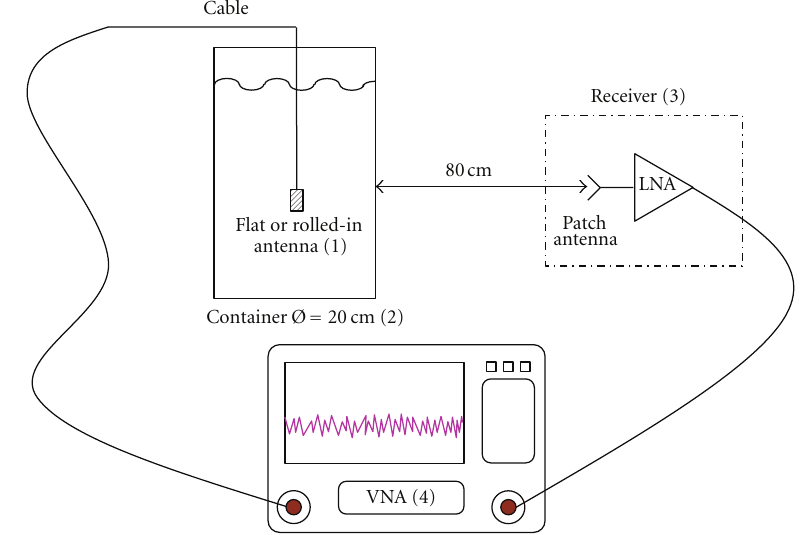
Figure 9: Structure of the system.